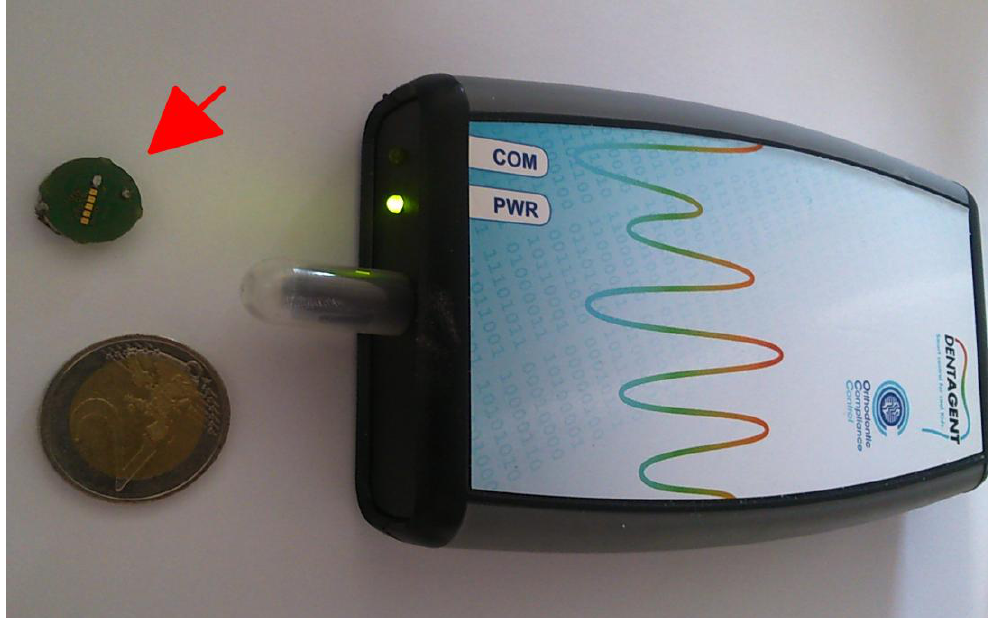
Figure 6. Picture of the commercial temperature logger system. The arrow points to the RFID readable temperature logger. The RFID reader station with USB connection to a PC is shown on the right. Acknowledgments: The project was founded by the Austrian Research Promotion Agency (FFG) under the IDs #850265 and